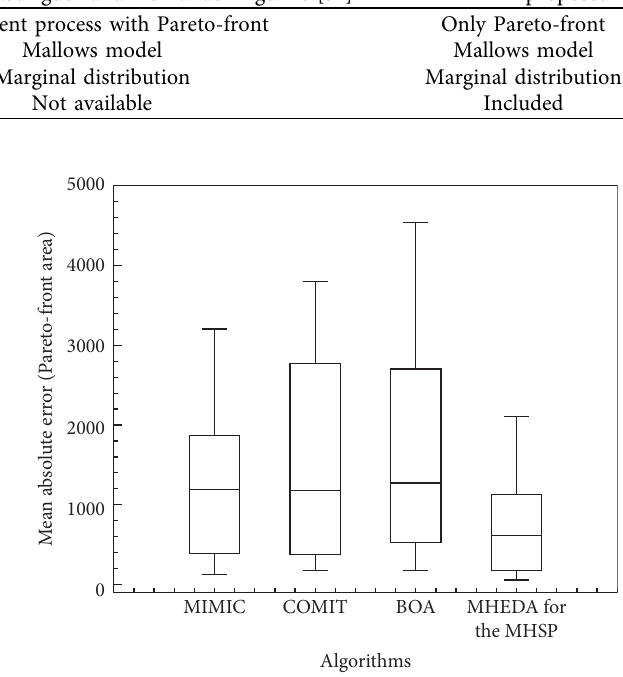
Figure 8: Comparison results for the MHSP using the mean ab- solute